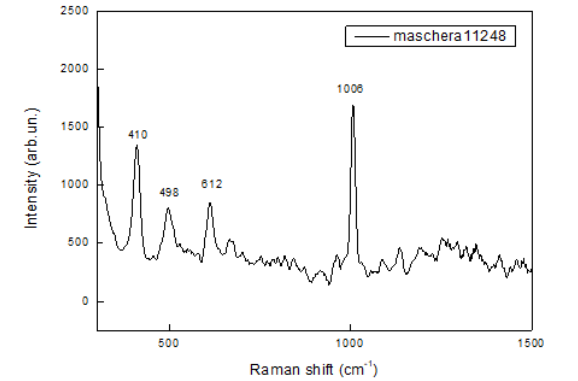
Figure 8. The raman spectrum shows bands at 410, 498 and 612 cm-1 attributable to hematite pigment and a band at 1006 cm−1 identifiable with gypsum. Raman spectra are acquired on red pigment in three different points of clay mask fragment n°